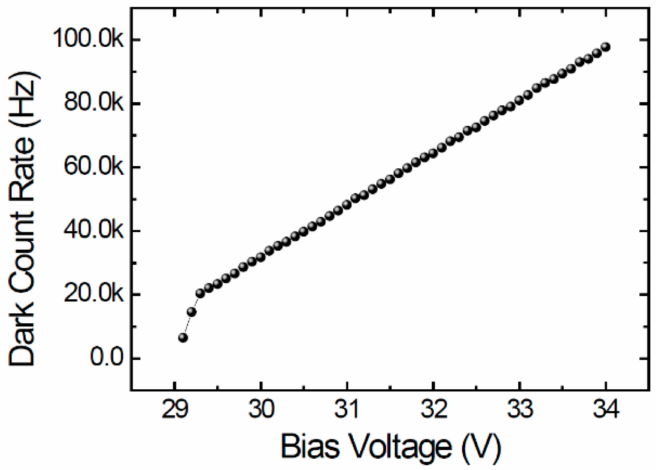
Figure 7. Measured dark-count rate (DCR) of the SPAD as a function of bias